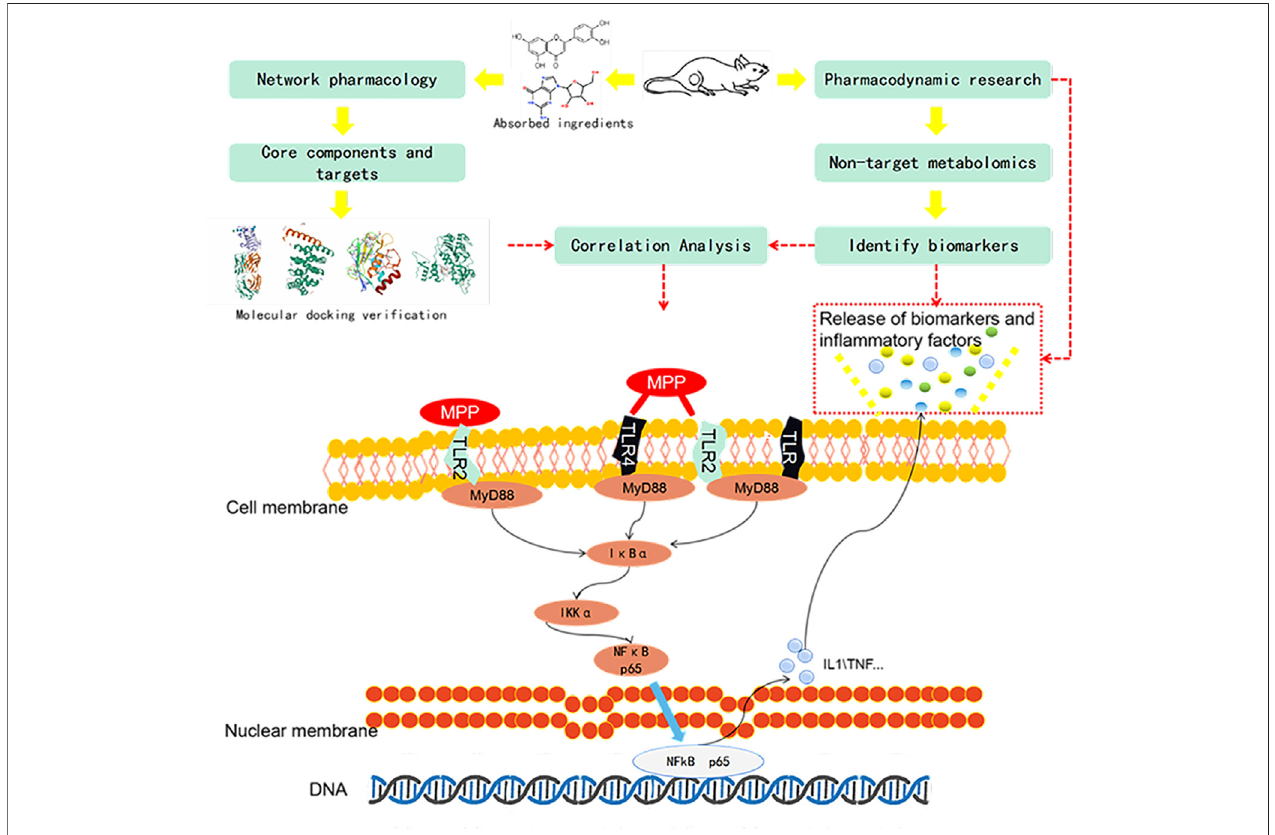
FIGURE 1 | Process design